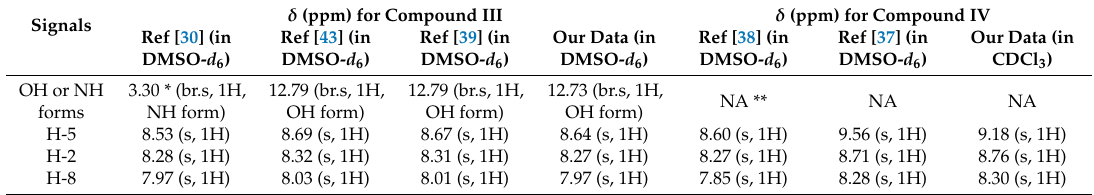
Table 1. Reported and our data for 1 H ‐ NMR spectroscopies of III and